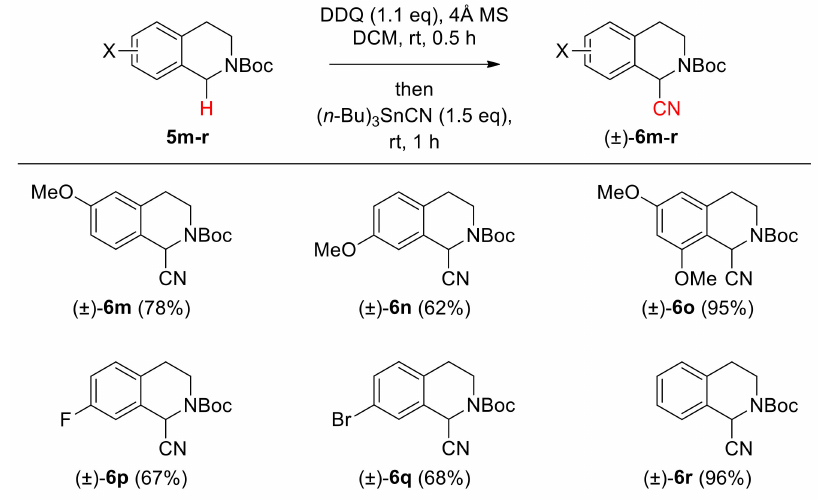
Figure 3. Reaction scope with electronically diverse N -Boc THIQs a,b . a Reaction conditions: N -Boc-THIQ 5m - r (0.3 mmol, 1 equivalent), DDQ (1.1 equivalent) in DCM (3.0 mL) at room temperature under argon atmosphere for 0.5 h, then (n-Bu) 3 SnCN (1.5 equivalent) for 1 h. b Based on the isolated product using chromatography after